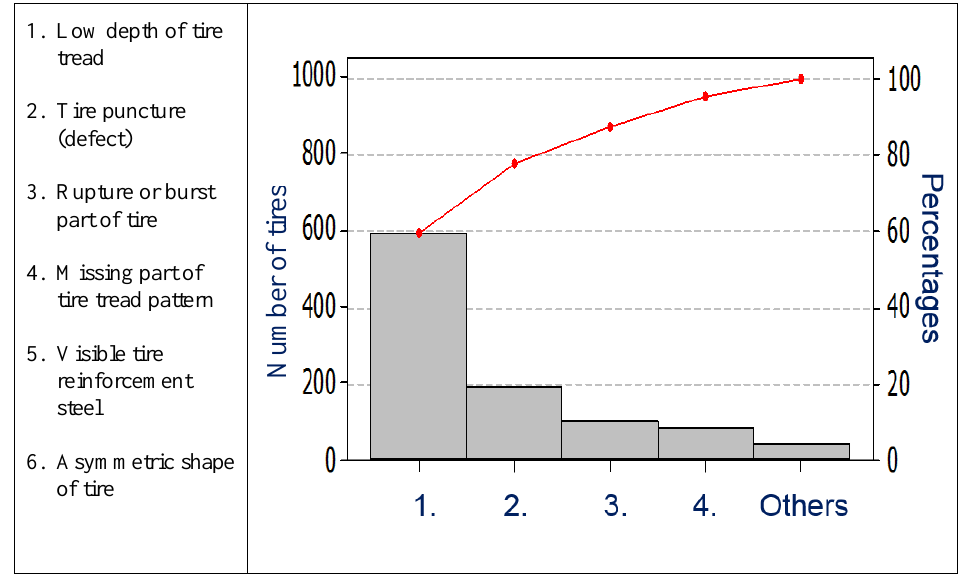
Figure 3 – Pareto analysis of tire